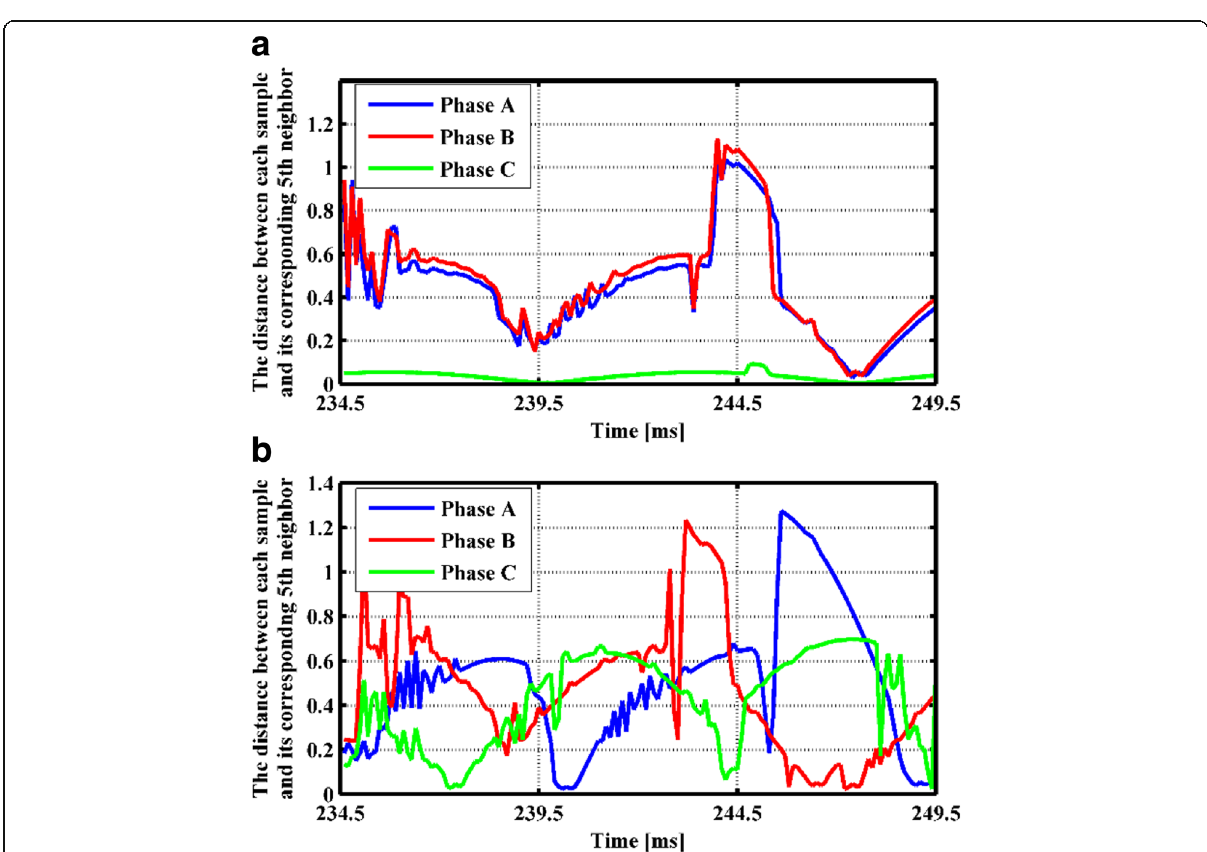
Fig. 6 The distance between each sample and its corresponding neighbor in the analysis window. a Fault AB, negligible resistance, t0 = 0.2345 s. b Fault ABC, negligible resistance, t0 = 0.2345 s